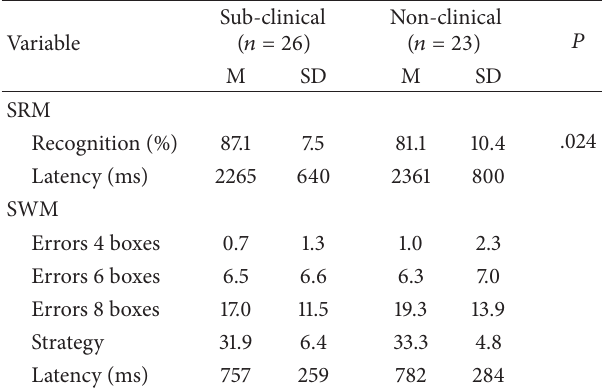
Table 3: Means and standard deviations in thesub-clinical and non- clinical groups for the SRM and SWM task